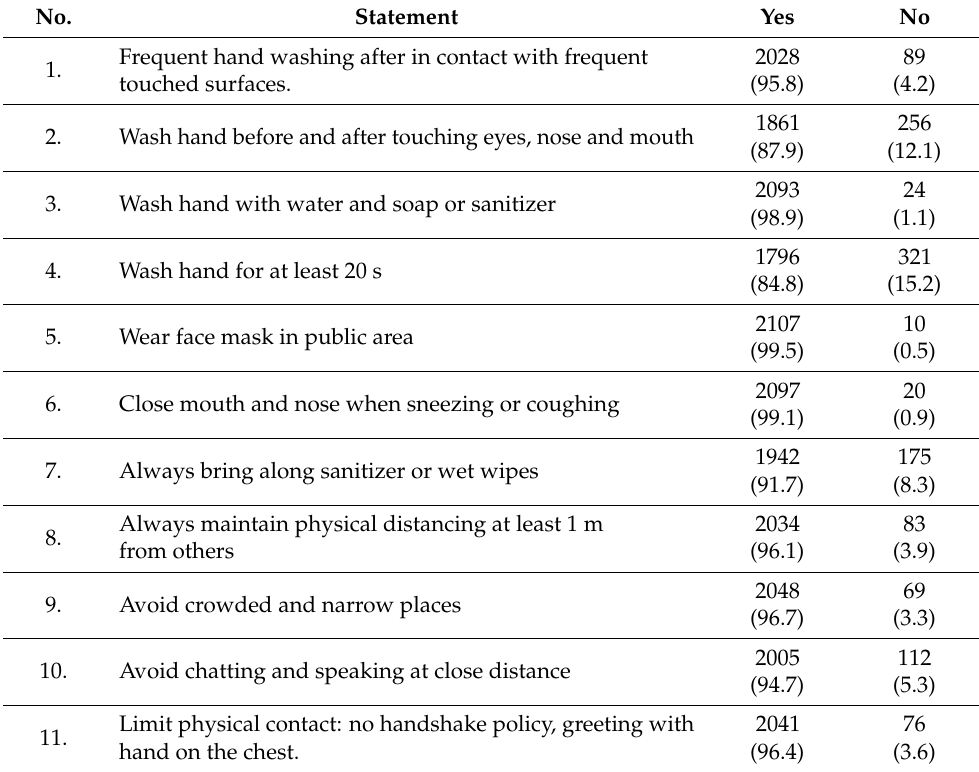
Table 6. Practice of preventive measures during the coronavirus disease 2019 (COVID-19) pandemic ( n =